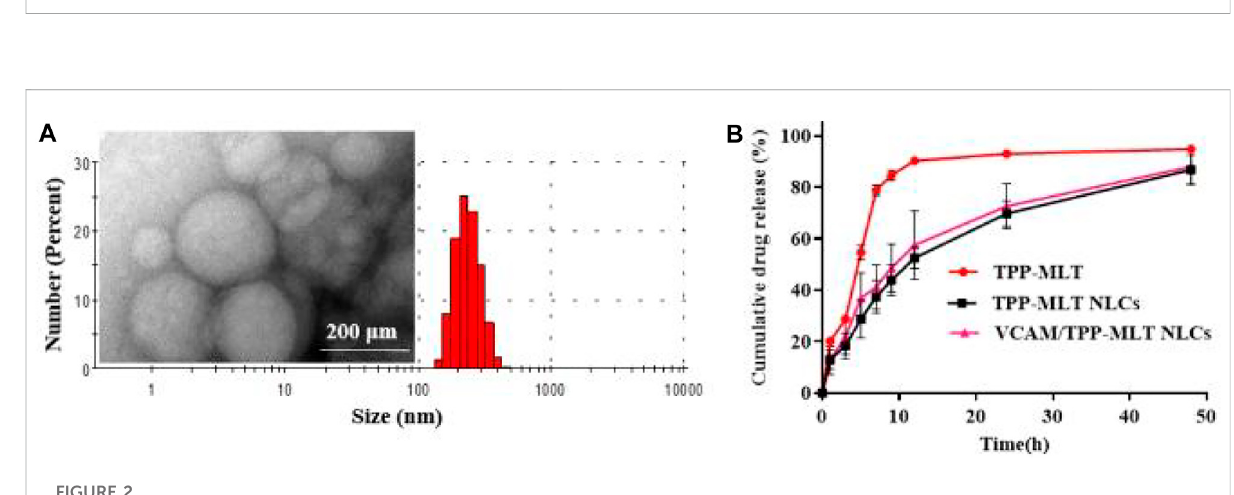
FIGURE 1 A schematic diagram of VCAM@TPP-MLT NLCs for the treatment of acute lung injury.